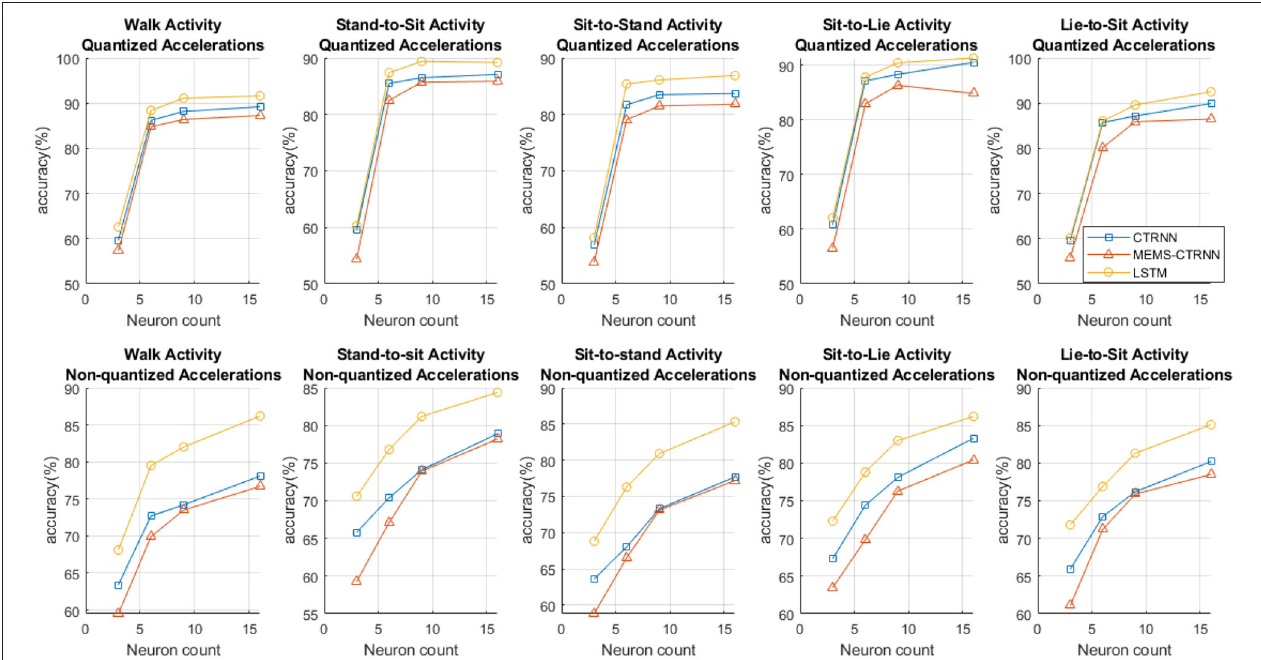
FIGURE 5 | The accuracy charts for LSTM, CTRNN, and MEMS-CTRNN across 5 activities and 5 subjects. The X-axis represents the number of neurons in the hidden layer (3, 6, 9, 16).